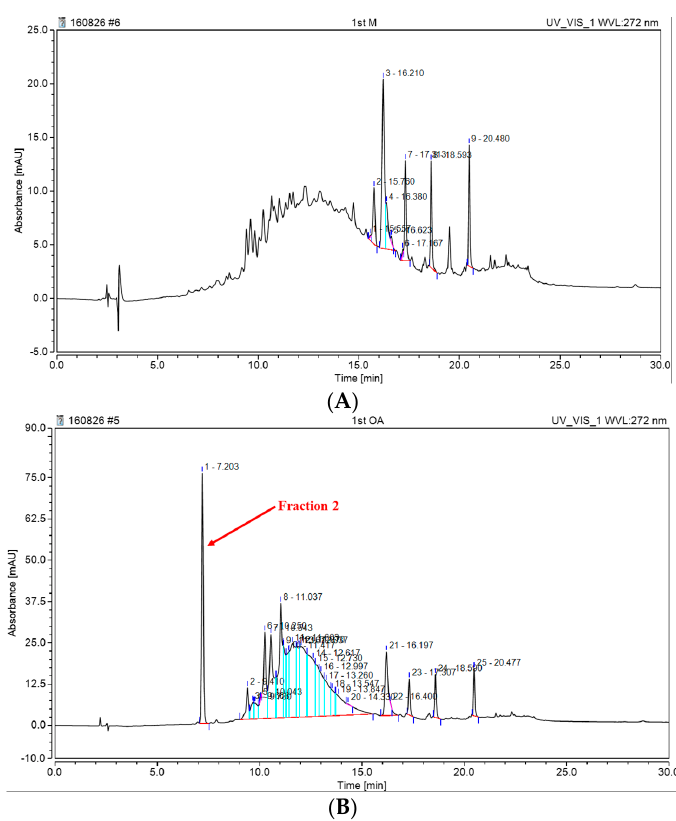
Figure 11. HPLC patterns of monomeric and oligomeric anthocyanins. ( A ) Before biosynthesis; ( B ) after biosynthesis using glucosidase.